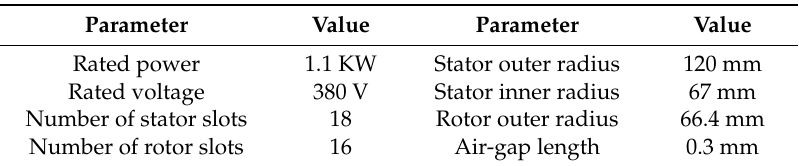
Figure 2. 3D model of the motor.